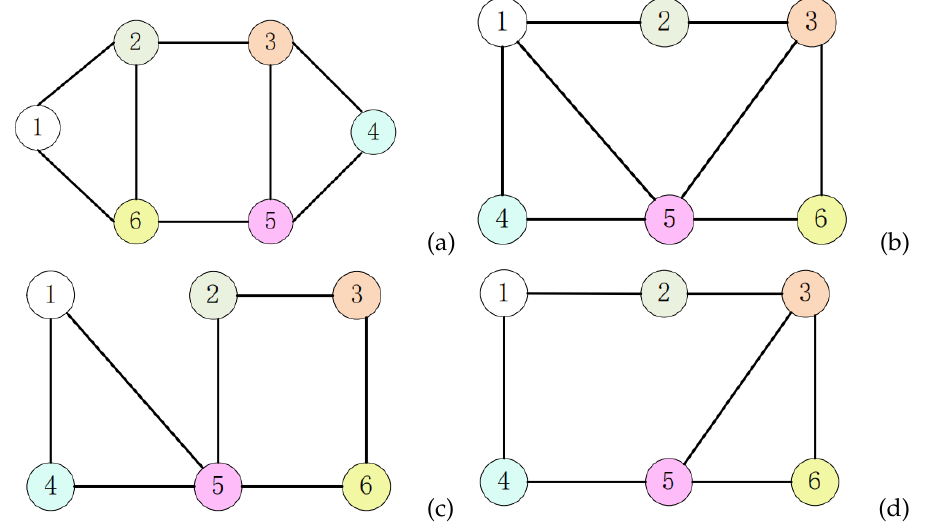
Figure 2. The switching topology